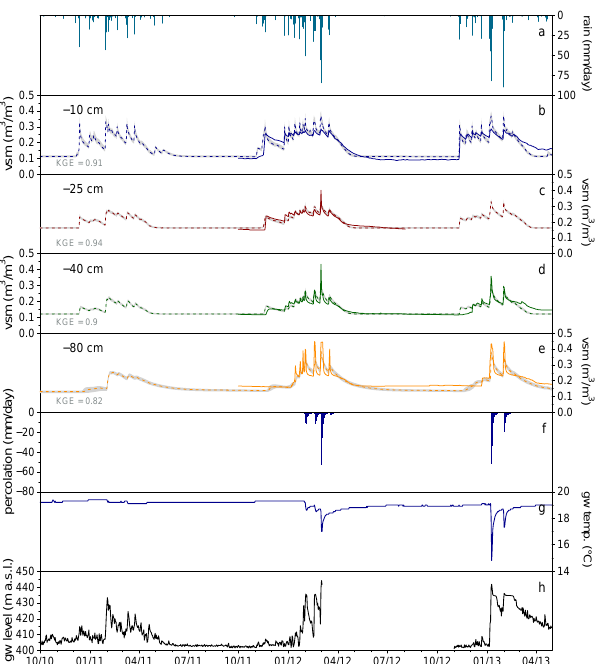
Figure 7. Time series of rainfall (a) , simulated and observed vol- umetric water content for soil moisture plot SM-1 (b–e) , Hydrus- 1D simulated percolation (f) , water temperature (g) and piezomet- ric water levels (h) in a nearby groundwater well. The grey shaded area represents the 95% confidence interval of soil moisture based on model parameter sets obtained using SCEM after fulfilment of the convergence criterion.